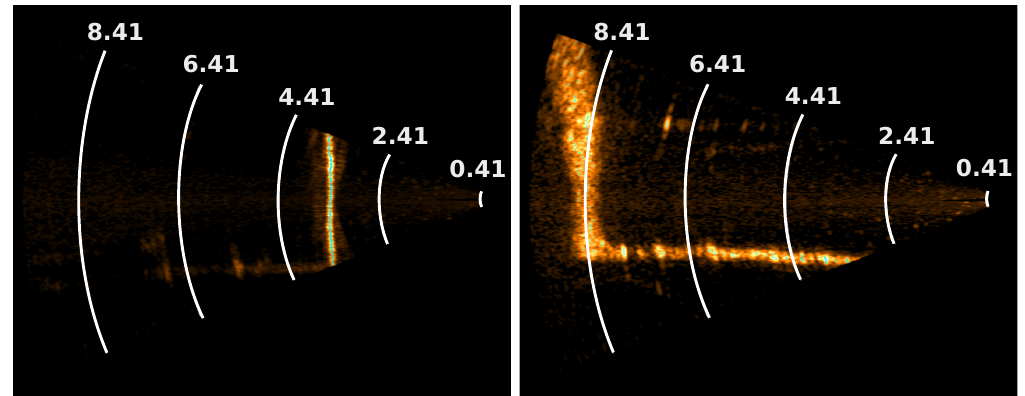
Figure 7. Multi-beam echo-sounder swaths under two different incidence angles. ( Left ) Almost perpendicular incidence (see the red line in Figure 8); ( Right ) Grazing angle (see the green line in Figure 8). The swath is wider in the second case. Distances are given in